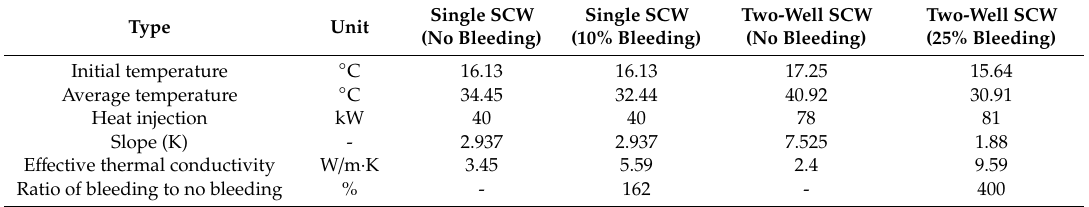
Table 7. Comparison on the measuring of thermal conductivity in various bleeding